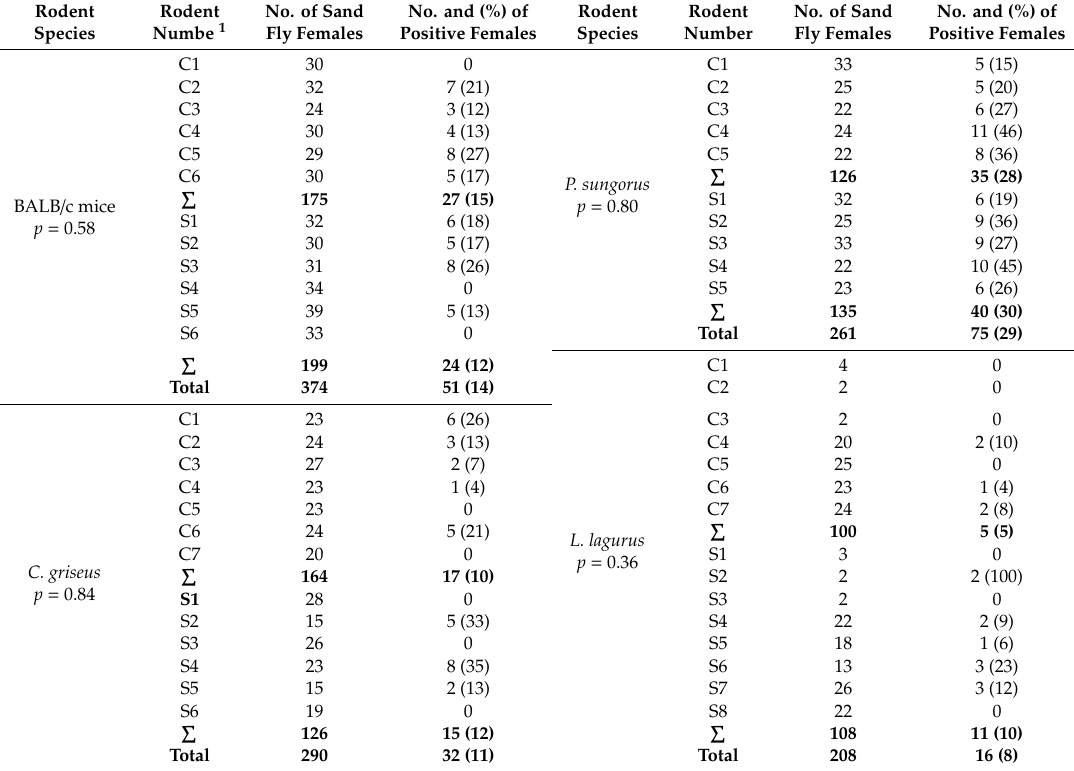
Rodent Rodent No. of Sand No. and (%) of Species Number Fly Females Positive Females